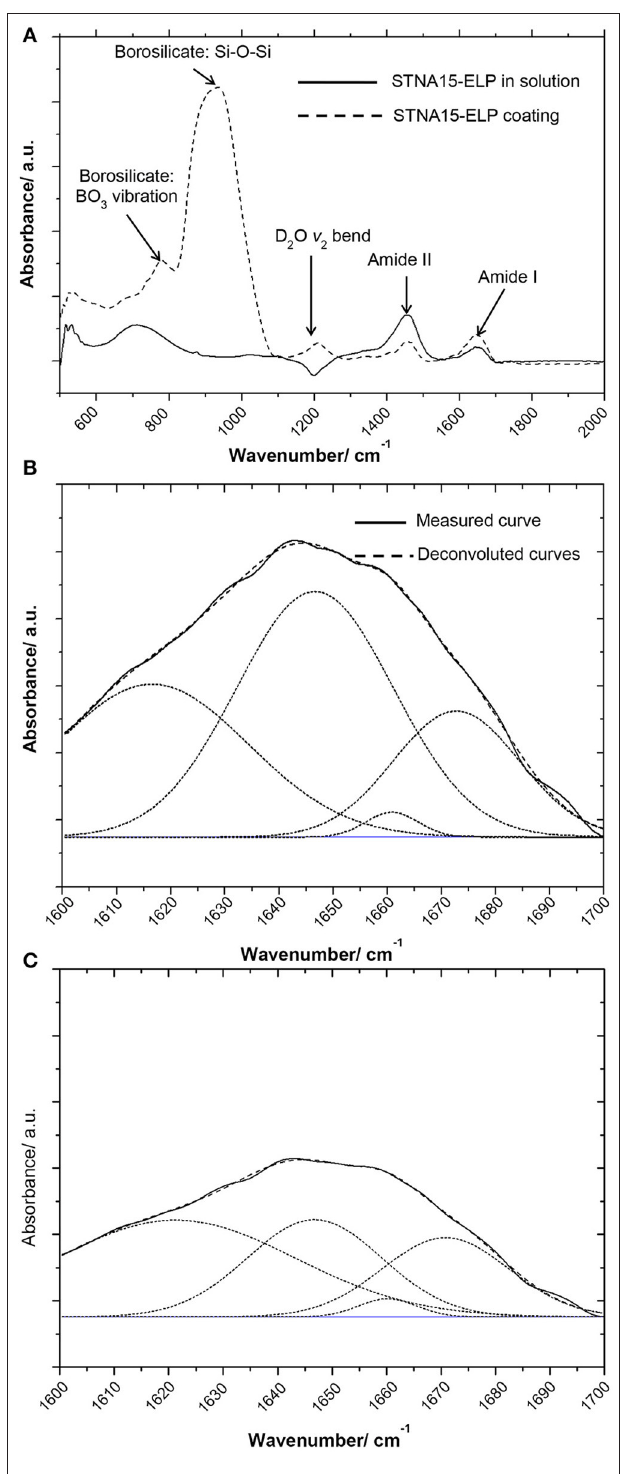
FIGURE 2 | FTIR results of (A) coated ELP (dotted line) vs. STNA15-ELP in solution (solid line) showing the difference in the absorbance, especially noticeable difference in the intensity of amide I and II peaks. The Gaussian fit deconvoluted amide I band of (B) STNA15-ELP coated on glass and (C) protein in solution. The dashed line represents the data and the smooth line is the Gaussian